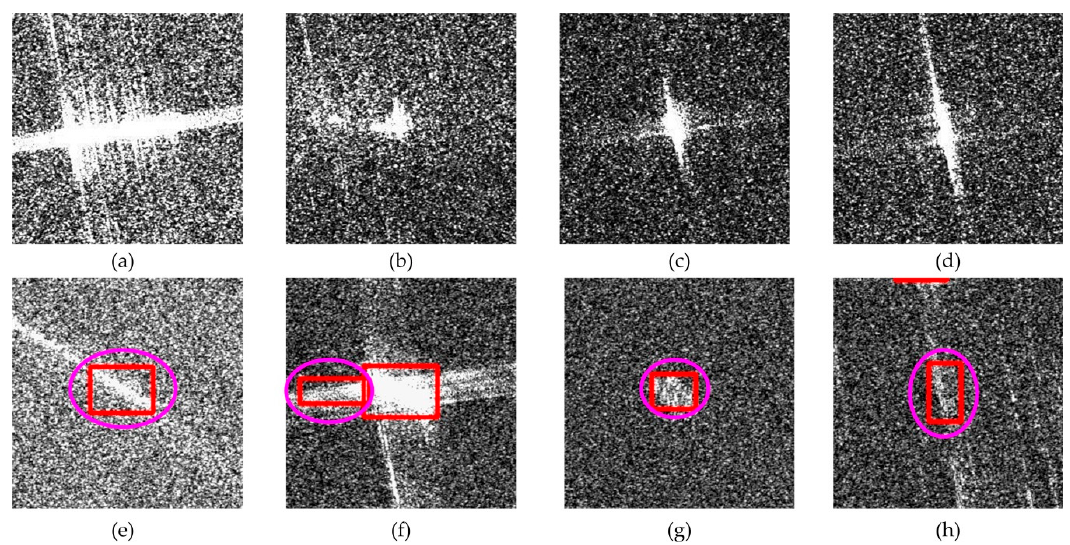
Figure 10. The ship detection results of the Cosmo-SkyMed imagery with the red rectangles indicating the location of ships.